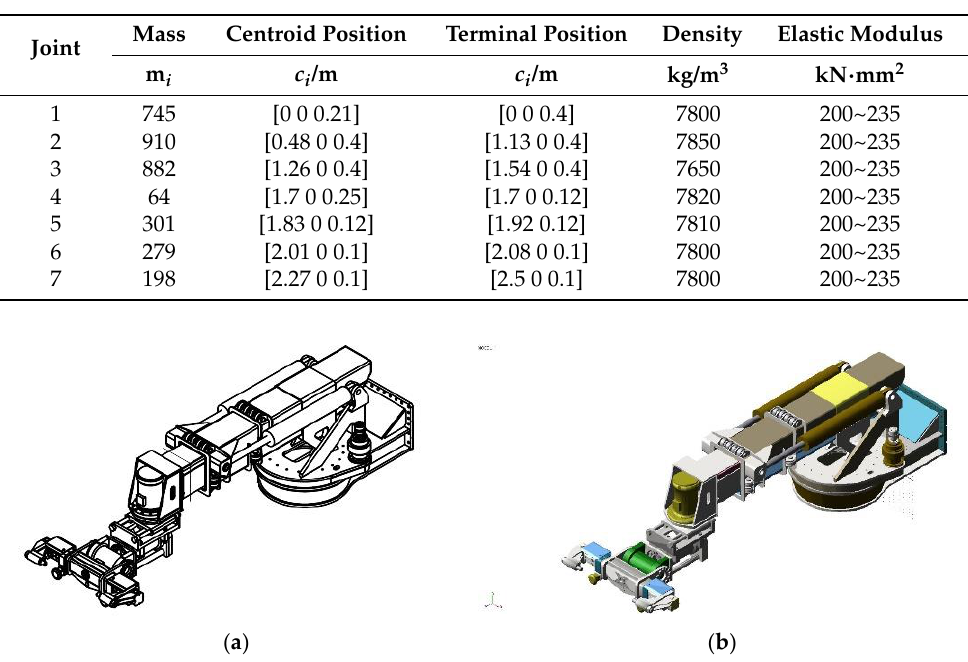
Figure 5. ( a ) Heavy-duty manipulator; ( b ) Adams dynamic model.